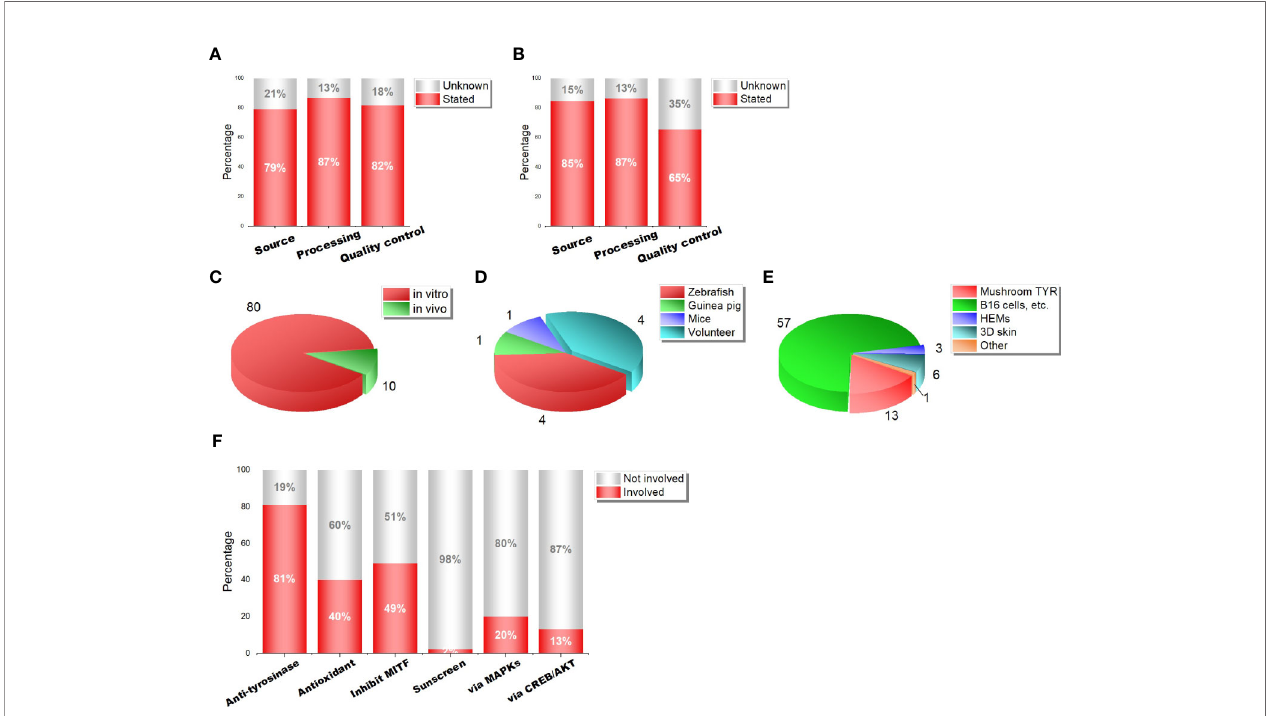
FIGURE 2 | Scienti fi city and academic value of 90 Asian herbal studies. (A) the quality control of ingredient-related studies; (B) the quality control of mixture-related studies (herbal formula, extracts, and combined studies); (C) the number of in vitro and in vivo studies; (D) the models of in vivo studies; (E) the models of in vitro studies; (F) the percentage of different mechanisms involved in